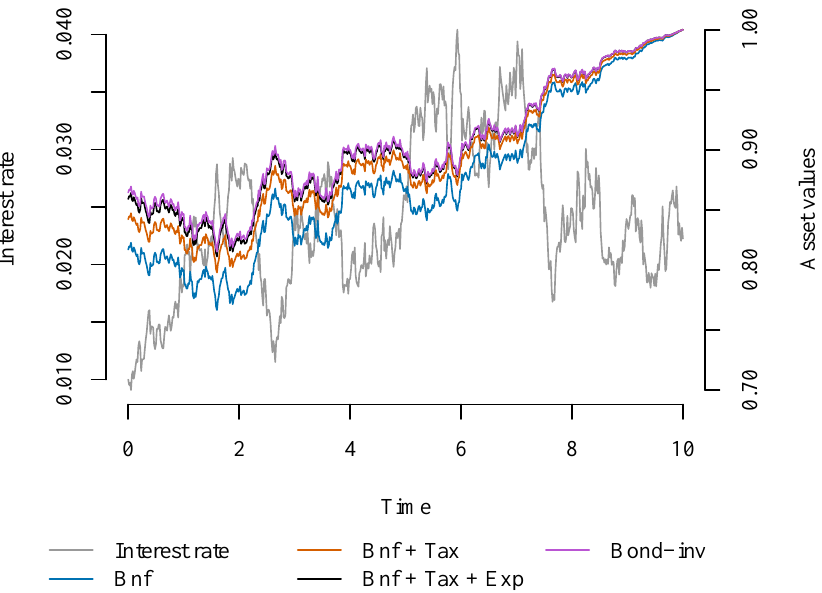
Figure 2. A simulated path for the CIR interest rate model (left axis) and relevant associated value processes (right axis). The illustrated lines are similar to Figure 1. Here, in the CIR case, the value of the investment in the bond does not coincide with the total value of the hedging portfolio, and in particular, we see that the value of the bond investment (the purple line “Bond-inv”) is larger than the value of the portfolio, because the investment in the bond is